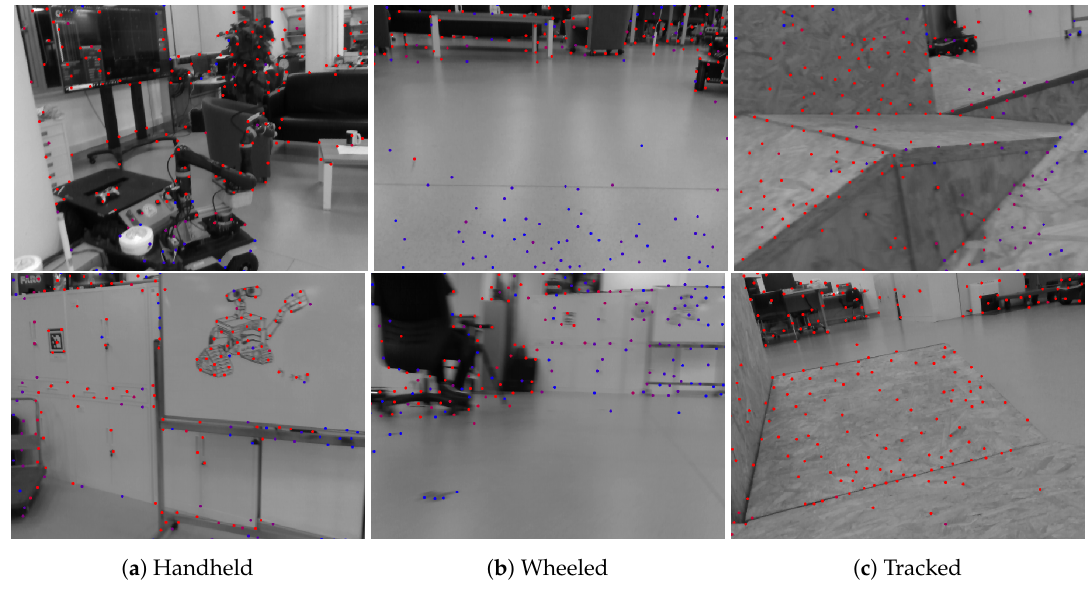
Figure 19. Selected frames from the handheld, wheeled and tracked